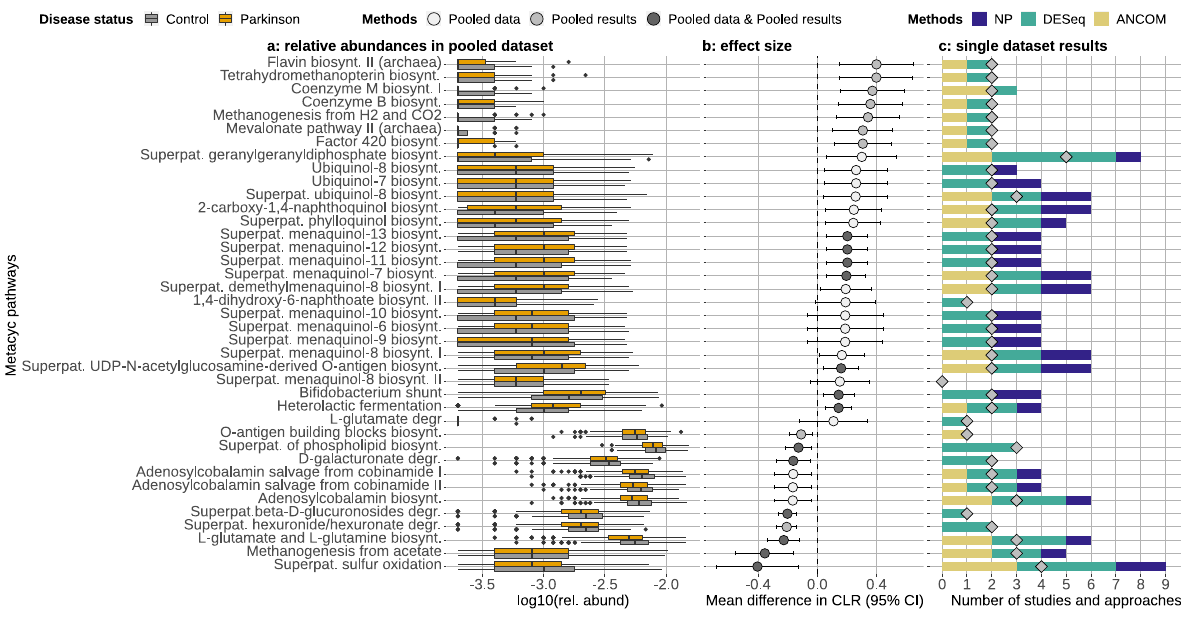
Fig. 6 Metabolic pathways showing a signi fi cant difference in abundance between PD patients and controls. Only selected relevant pathways are shown (a full overview is reported in Supplementary Fig. 14). The relative abundances of the pathways retrieved from the rare fi ed pooled data are reported in panel a . Effect sizes were estimated via the mean difference in CLR (panel b ) using a random-effect meta- analysis (Pooled Results approach). This was calculated for all pathways resulting differentially abundant in the Pooled results or Pooled data approaches. The color of the dots indicates which of the two above approaches detected the pathway differentially abundant. Pathways more abundant in controls have an effect size shifted to the left, whereas pathways more abundant in PD have an effect size shifted to the right. Panel c shows the number of times each pathway was detected differentially abundant between PD patients and controls across studies (diamonds) and approaches (bars). We used ten studies and three approaches, hence the maximum number of times a pathway can be detected differentially abundant is